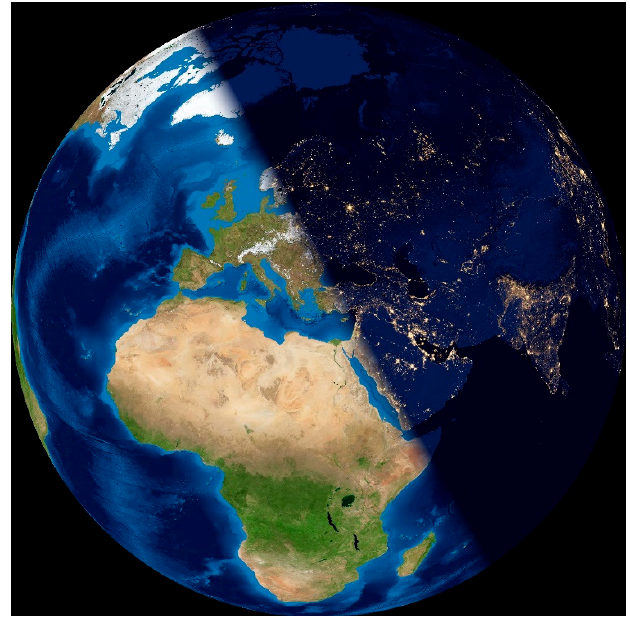
Figure 1. At any given moment, half of the Earth’s surface experiences night. Data by NASA Blue Marble and Black Marble, via John Walker ‘s webtool “Earth and moon viewer” [4].